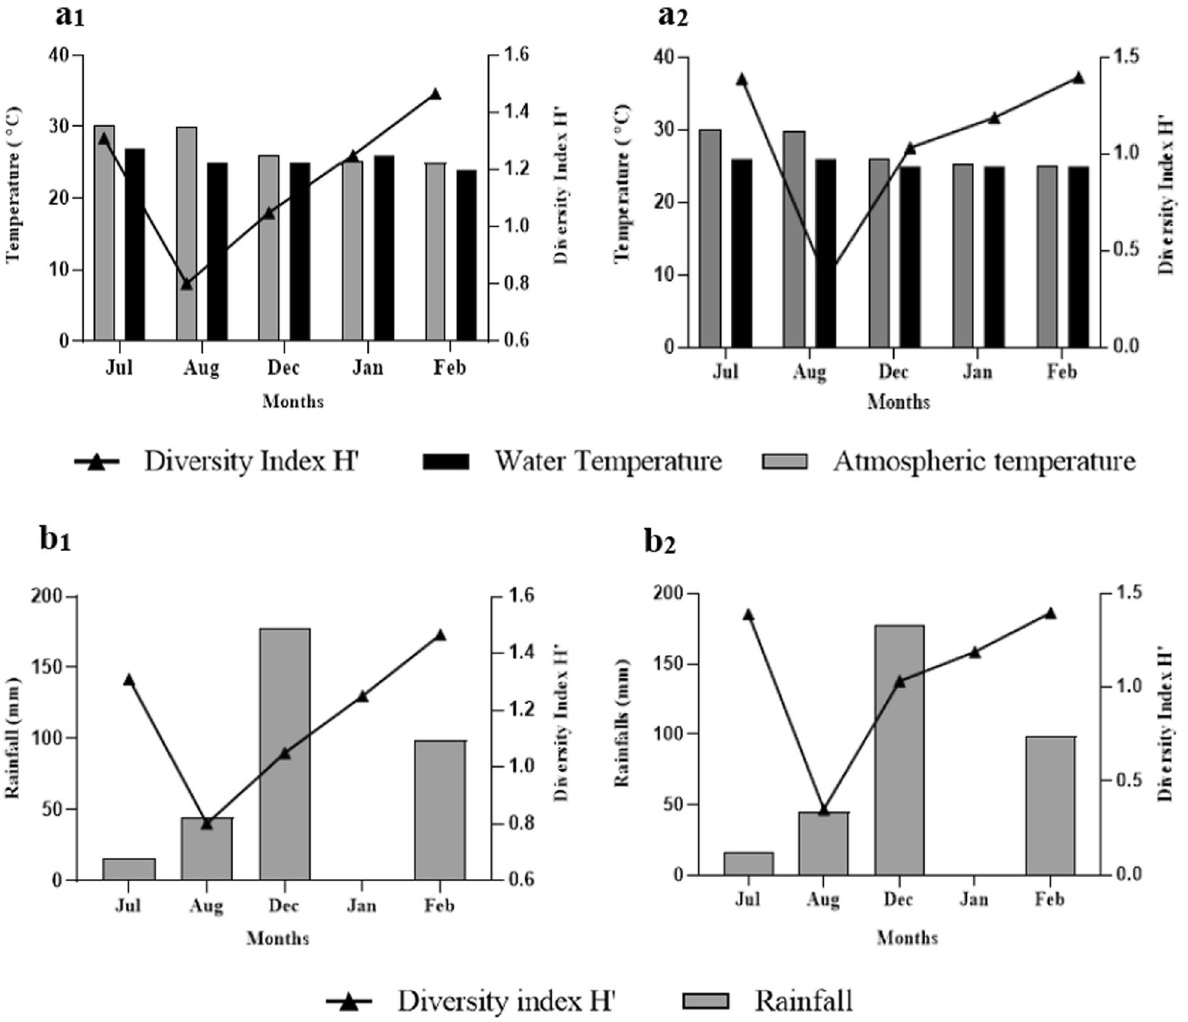
Fig. 3 Zooplankton diversity fluctuation in Vavuniya reservoir (left) and Thandikulam reservoir (right) during July 2018–February 2019. a 1 and a 2 Atmospheric and Water temperature. b 1 and b 2